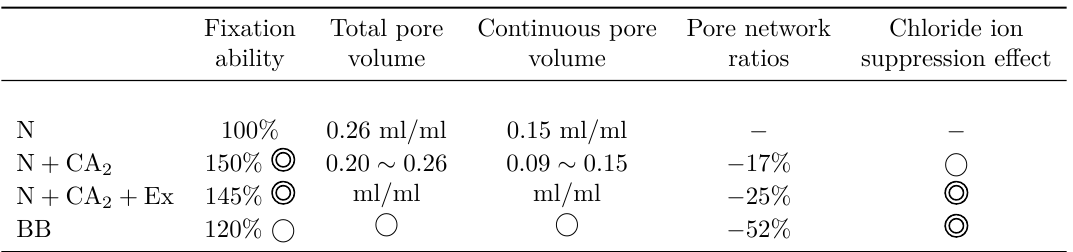
Table 5. Summary of material characteristics and penetration behaviour of chloride